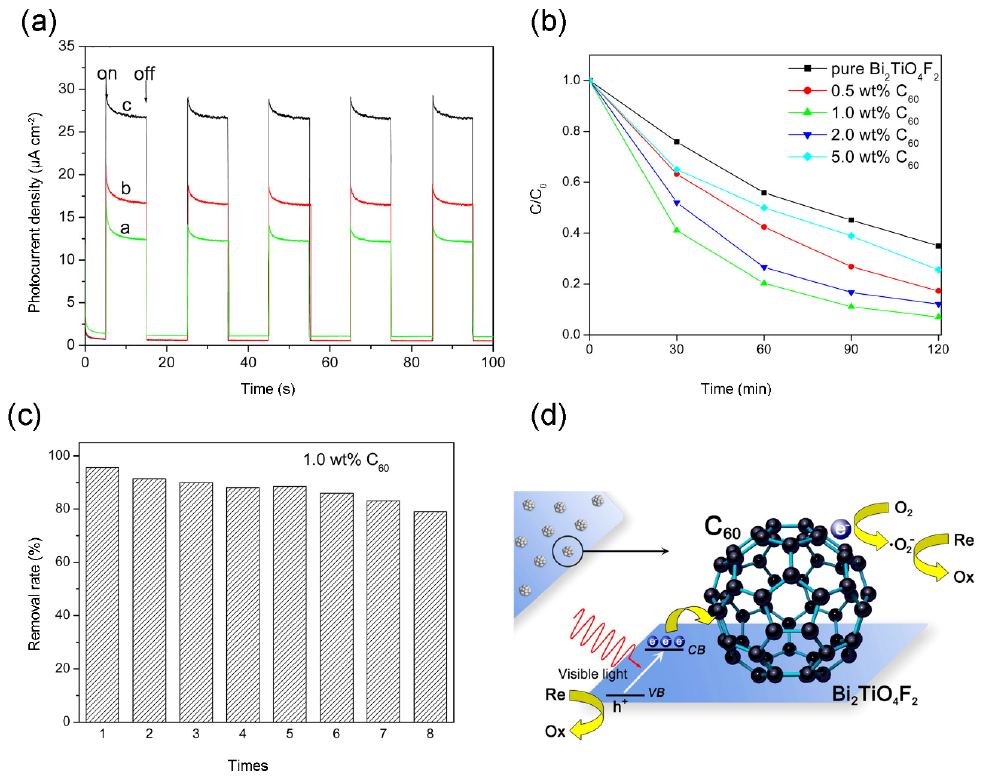
Figure 6. ( a ) Photocurrent responses of Bi 2 TiO 4 F 2 , C 60 (1 wt %) + Bi 2 TiO 4 F 2 mixture and 1 wt % C 60 /Bi 2 TiO 4 F 2 . ( b ) Photocatalytic performance towards RhB degradation. ( c ) Recyclability test of the as-prepared composites 1 wt % C 60 /Bi 2 TiO 4 F 2 . ( d ) The mechanism of C 60 /Bi 2 TiO 4 F 2 photocatalyst is